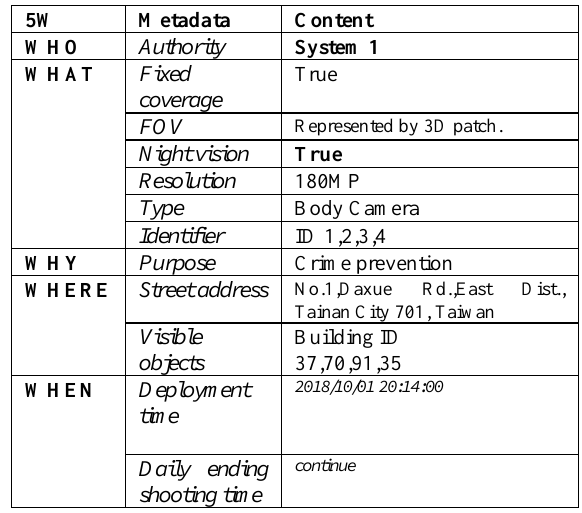
Table 2. System 1’s CCTV Metadata designed